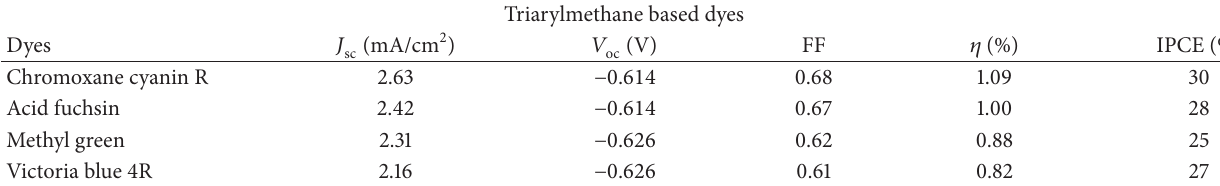
Table 3: DSSC performance parameters of triarylmethane based dyes.